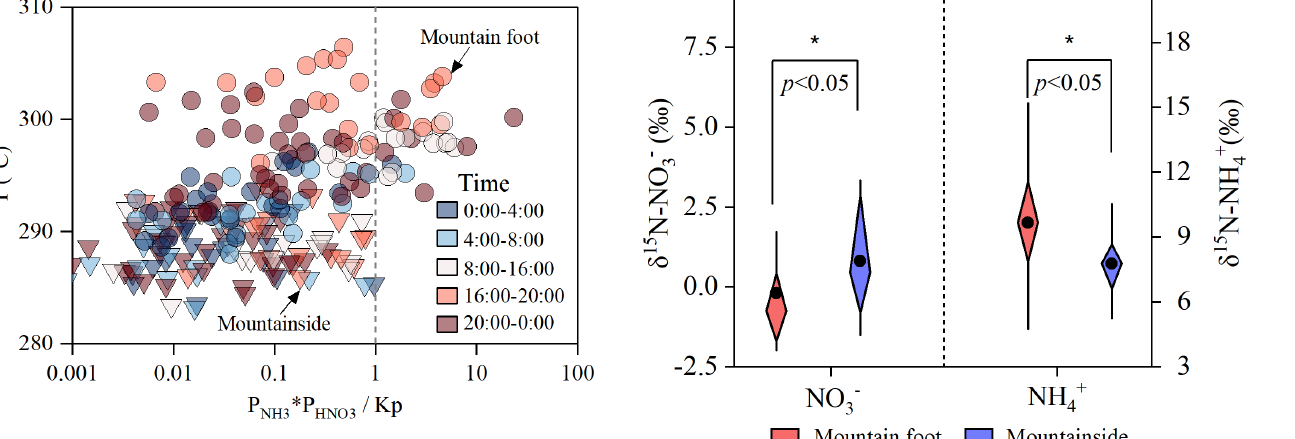
Figure 9. Temperature dependence of the ratio of the product of the partial pressures of NH 3 and HNO 3 with the dry dissociation constant of NH 4 NO 3 .